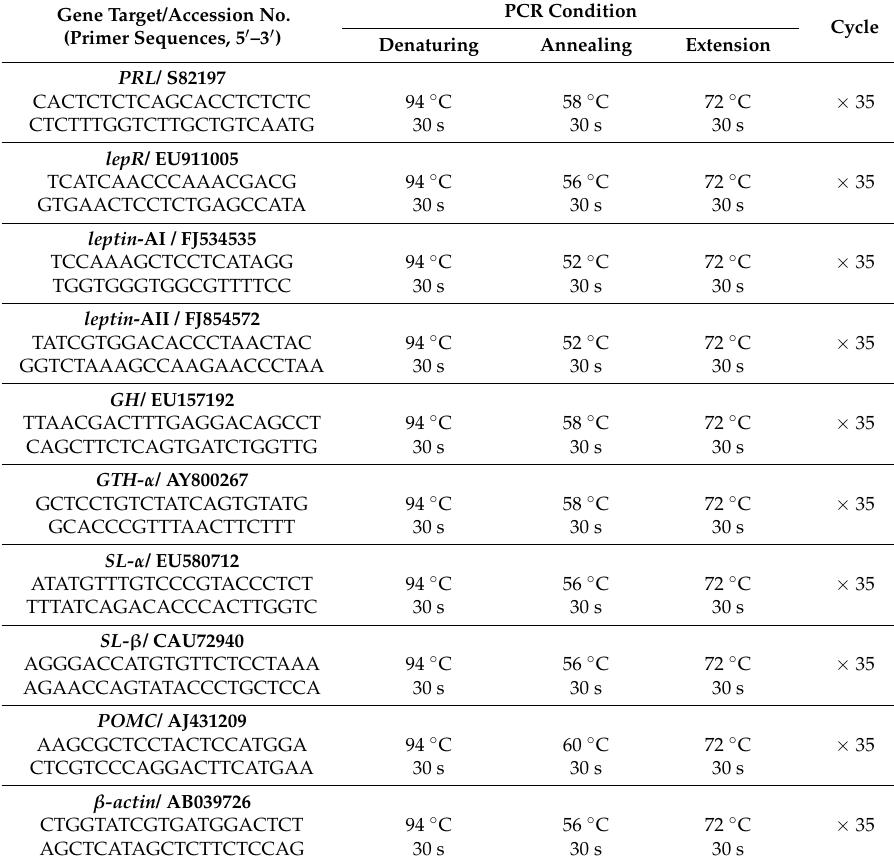
Table 1. Primers and amplification conditions for the qPCR analysis in this